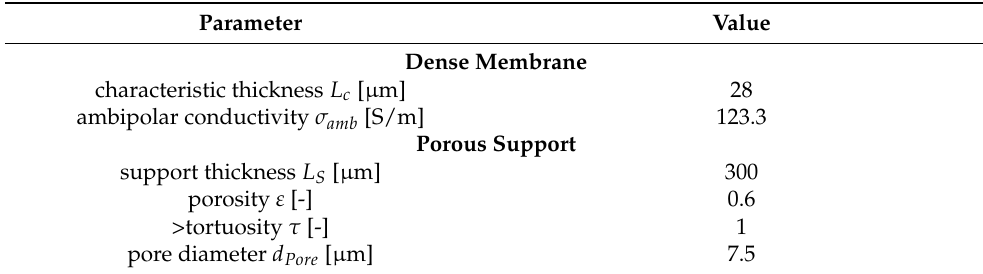
Table 5. Exemplary parameter set necessary to reach SL ≤ 10 % in SF operation for a high conductive membrane; Experimental conditions as in Table